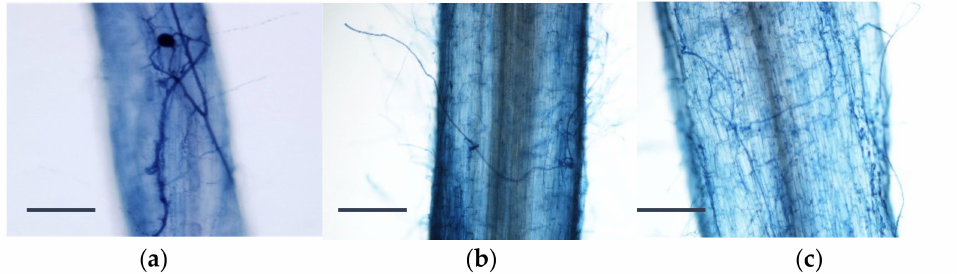
Figure 9. Detail ‘Troianella’ landrace root colonized by AM fungi after 4 weeks from inoculation: ( a ) S. viscosum ; ( b ) F. mosseae ; ( c ) Commercial mix (Light microscopy images; Bar (a) = 0.1 mm; Bars (b) and (c) = 1.0